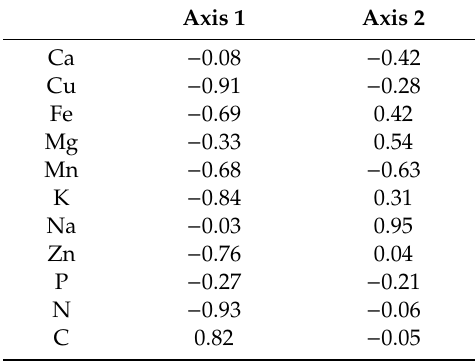
Figure 1. Principal component analysis (PCA) plot—multivariate analysis of stoichiometric relations in spider taxa and sexes. The first two axes are presented. Considering the 1st axis, females are separated from males primarily due to their relatively high concentration of C and low concentrations of N, Cu, K and Zn (see Table 2 and Figure 2 for detailed statistics). Similarly, Steatoda grossa is separated from the other taxa due to its relatively high concentration of C and low concentrations of N, Cu, K and Zn (the other taxa do not differ statistically from each other; see Table 2 and Figure 3 for statistics). Considering the 2nd axis, Tegenaria sp. forms a separate cluster mainly due to its relatively high concentrations of Na and Mg and low concentration of Mn. An opposite tendency is observed for Araneus sp., while Steatoda grossa together with Salticidae forms one cluster with intermediate concentrations of Na, Mg and Mn. These tendencies were confirmed by ANOVA performed independently for the 1st and 2nd axis scores ( p < 0.05; Figures 2–4). Table 1. Loadings values for all elements used in the PCA that variously contributed to the pattern observed in Figure 1. The mark ‘ − ‘ denotes vectors’ directions.